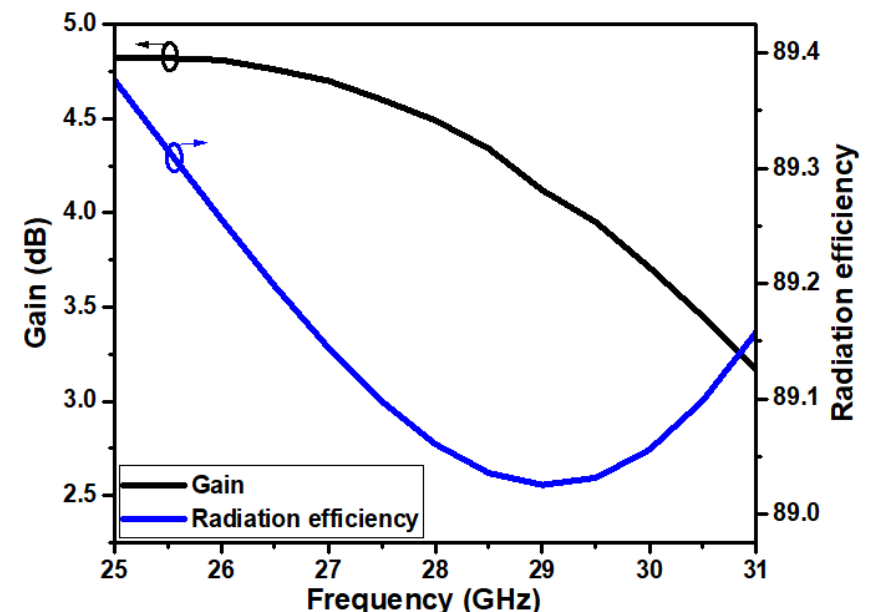
Figure 10. Gian and radiation efficiency of the proposed antenna.